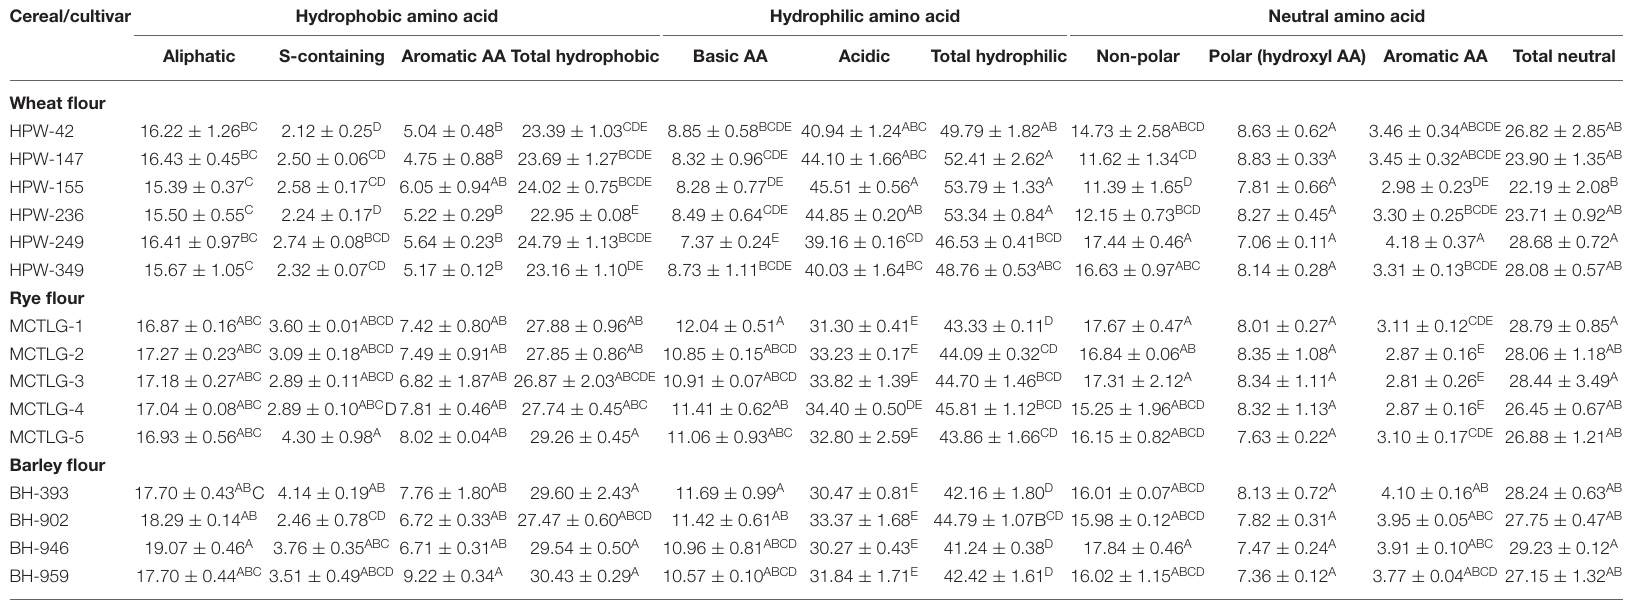
Total hydrophobic amino acid: Alanine + cysteine + valine + methionine + tryptophan + phenylalanine + isoleucine + leucine; total hydrophilic amino acid: Asparagine + aspartic acid + glutamine + glutamic acid + arginine + lysine; neutral amino acid: Serine + histidine + glycine + threonine + tyrosine + proline. Total AAS, total amino acid score-; EAAI, essential amino acid index; BV, biological value. Mean ± SD with different superscripts in a column differ significantly (p ≤ 0.05); n = 3 for each